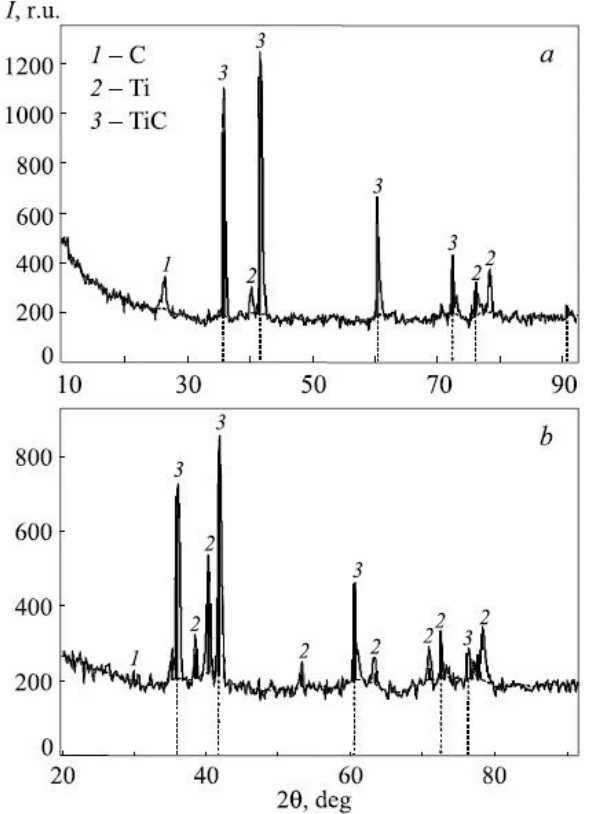
Figure 6. Diffraction patterns obtained from the surface of Ti samples subjected to ESA with a Figure 6. Di ff raction pa tt erns obtained from the surface of Ti samples subjected to ESA with a graphite electrode in di ff erent modes (W): ( a ) W = 0.3 J; ( b ) W = 1.0 J [6]. graphite electrode in different modes (W): ( a ) W = 0.3 J; ( b ) W = 1.0 J